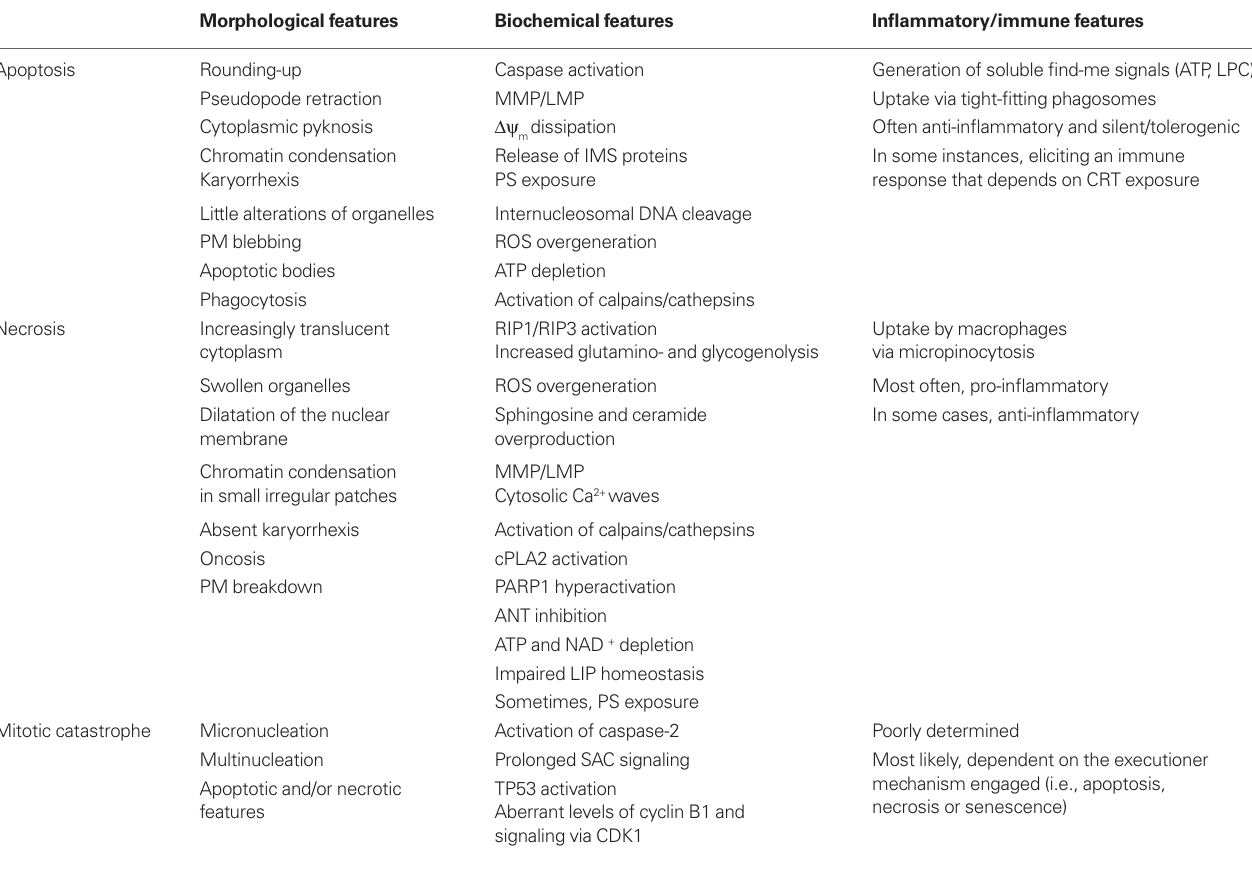
Table 1 | Main morphological, biochemical, and inflammatory/immunological features of apoptosis, necrosis, and mitotic